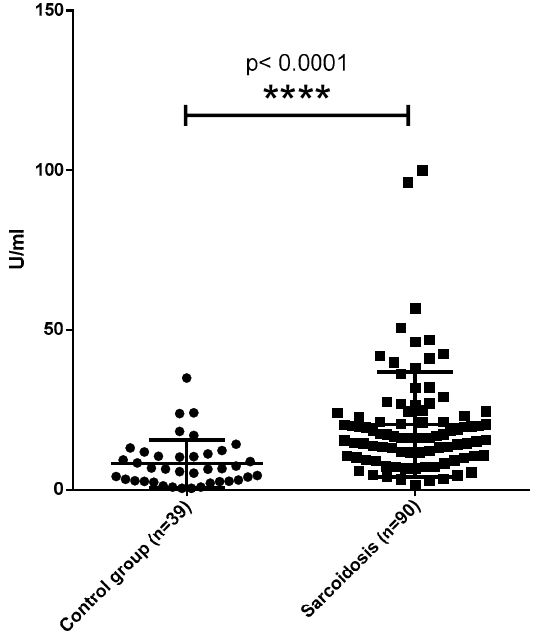
Figure 2. Levels of anti-vimentin autoantibodies in sera of patient with sarcoidosis and healthy subjects. **** p < 0.0001—in comparison with sarcoidosis and healthy subjects. Almost all patients with Löfgren syndrome included in the study had high levels of